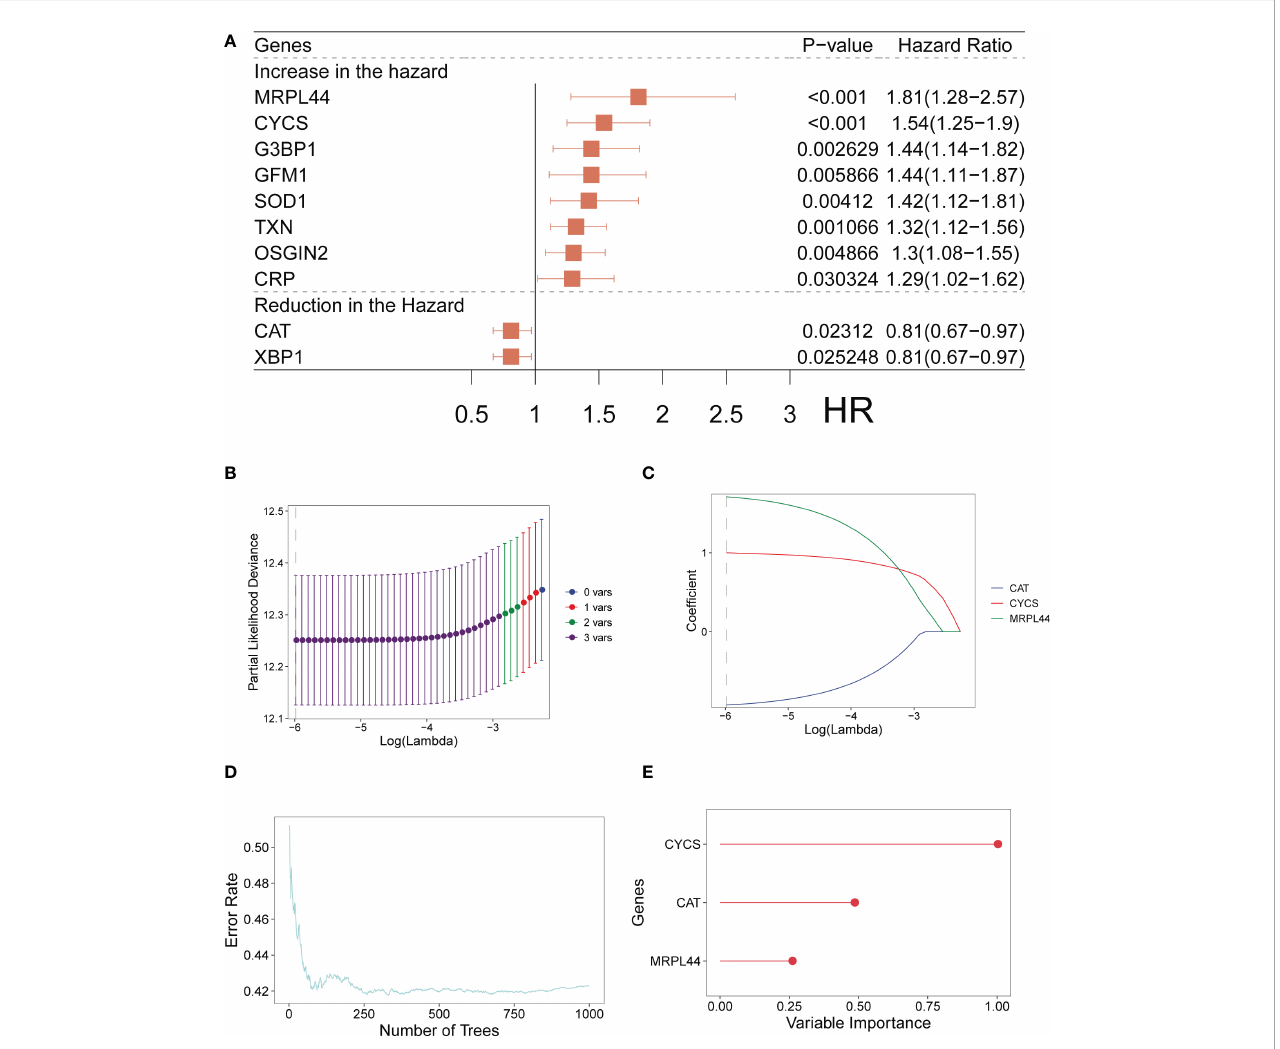
FIGURE 1 Establishment of OS-signature for patients with LUAD. (A) Forest plot for Univariate Cox regression analysis identifying ten oxidative stress related genes (MRPL44, CYCS, G3BP1, GEM1, SOD1, TXN, OSGIN2, CRP, CAT, and XBP1). (B, C) Lambda selection diagram for Least Absolute Shrinkage and Selection Operator (Lasso) analysis identifying three oxidative stress related genes (CAT, CYCS, and MRPL44) in the OS-signature. (D) The distribution of error rates in Random Survival Forest model. (E) The distribution of the variable relative importance of 12 TRP-related genes (variable